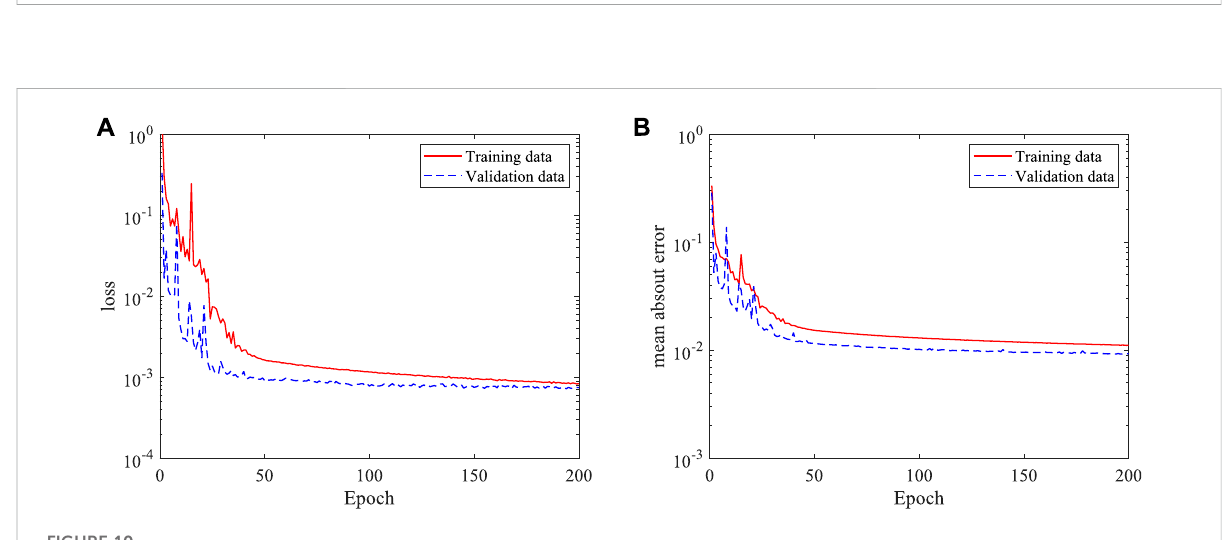
FIGURE 10 Histories of loss and mean absolute error of the DNN for 3D (axis-symmetric) fl ow prediction: (A) loss, and (B) mean absolute error.